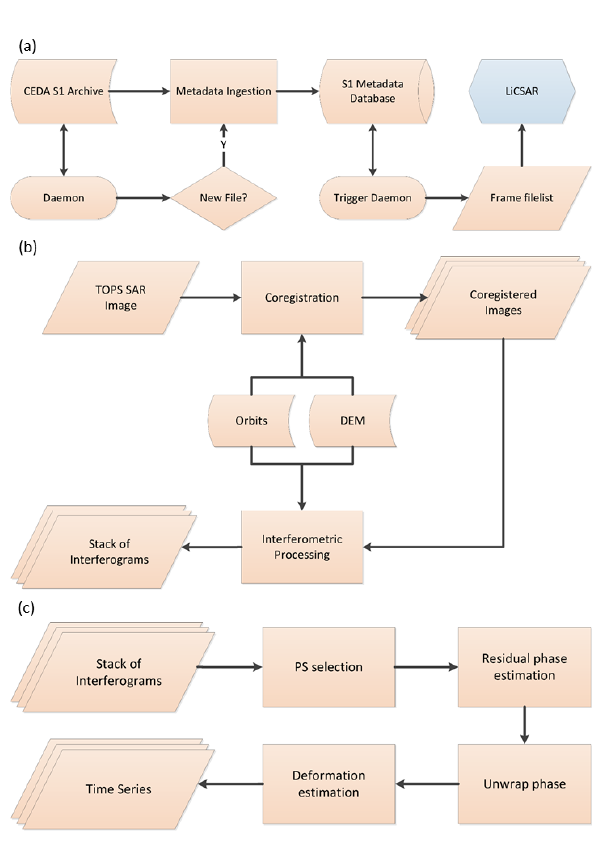
Figure 2. COMET InSAR automated system workflow. Panel (a) shows the database ingestion component and InSAR triggering mechanism. LiCSAR, the interferometric processing chain is shown in panel (b). Panel (c) depicts the time series estimation steps.